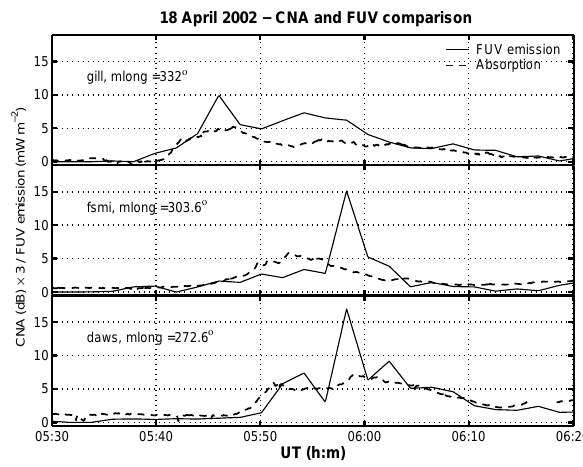
Fig. 13. Comparison of cosmic noise absorption with the electron energy flux derived from the FUV emission from closest pixel of the camera following Injection B on 18 April 2002. The stations, Gillam to Dawson, run east to west, respectively, and show the ap- parent westward motion of both the FUV emission and the CNA. The magnetic longitudes are marked on the